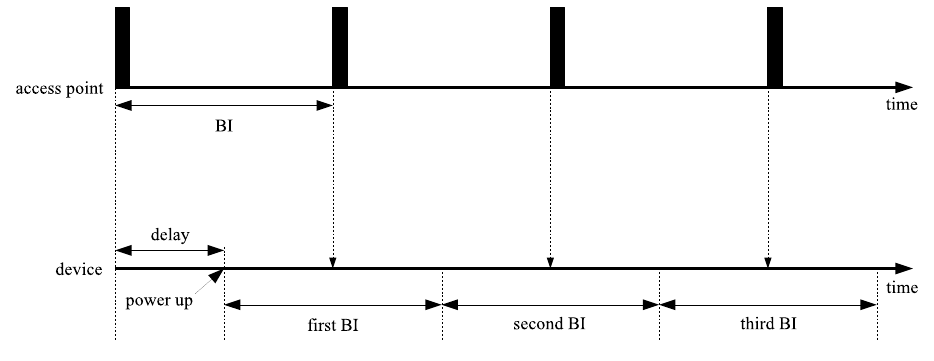
Figure 2. Periodic beacon arrival with random